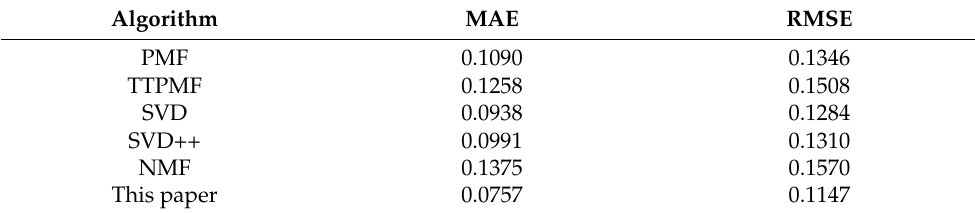
Table 4. Comparison between the proposed algorithm and other